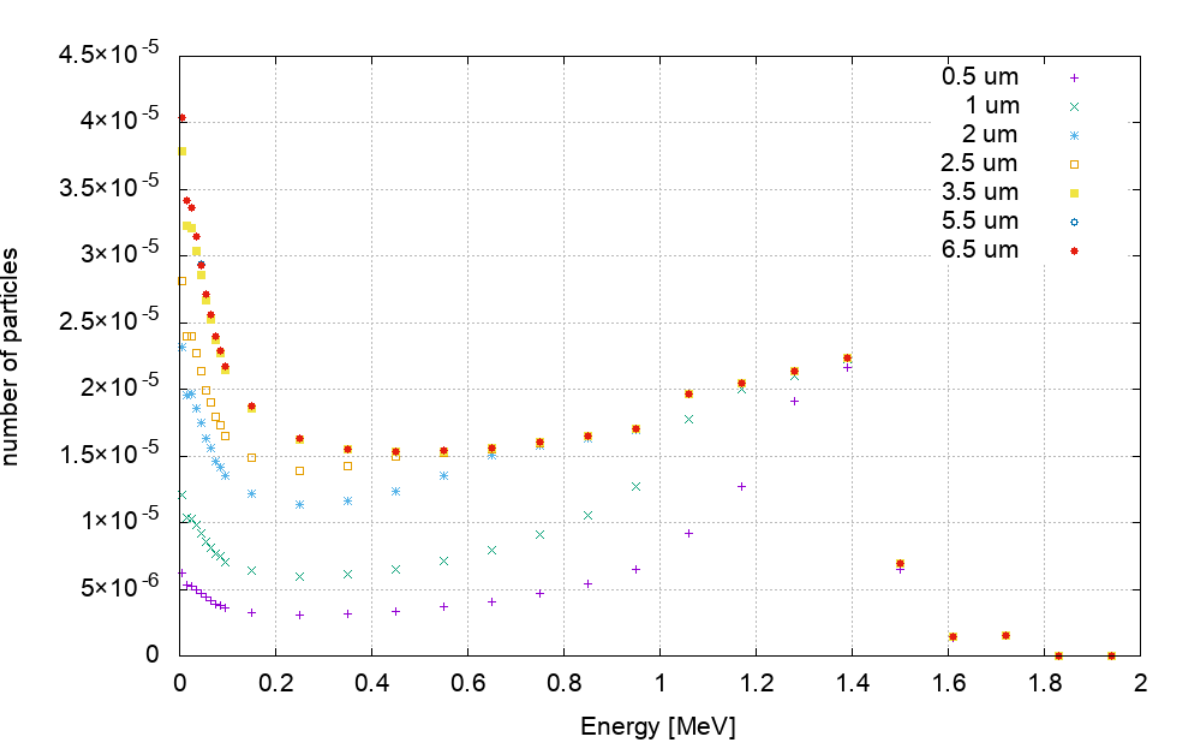
Figure 3. Energy spectrum on border of the crystal for different conversion layer thicknesses